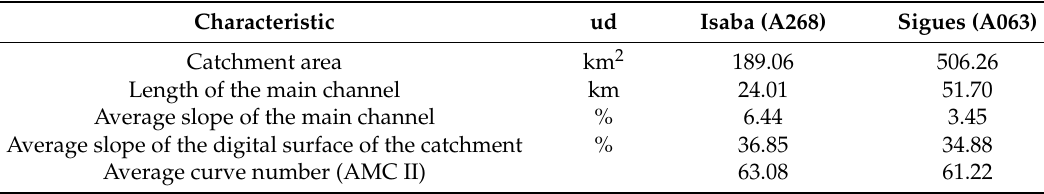
Figure 3. Altimetry representation of the Esca river basin with rain gauges (A063, A268, A259, and P016) and two stream gauges (A063, A268) that also have rain gauges. Table 1. Hydrological characteristics of the Esca river basins in Sigues and Isaba.